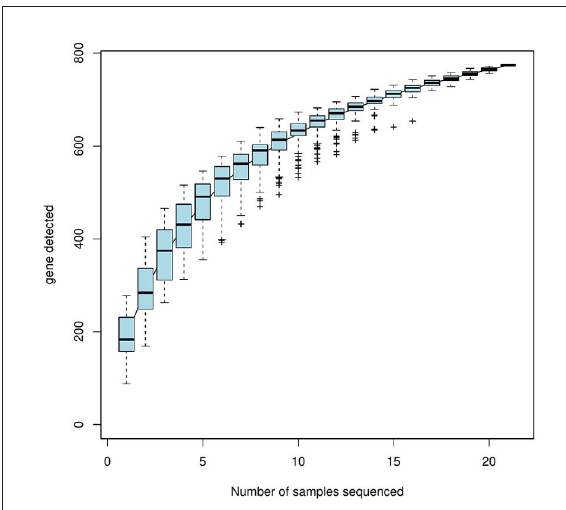
FIGURE2 Species accumulation curves (horizontal coordinate, sample size, vertical coordinate, and number of OTUs after sampling).